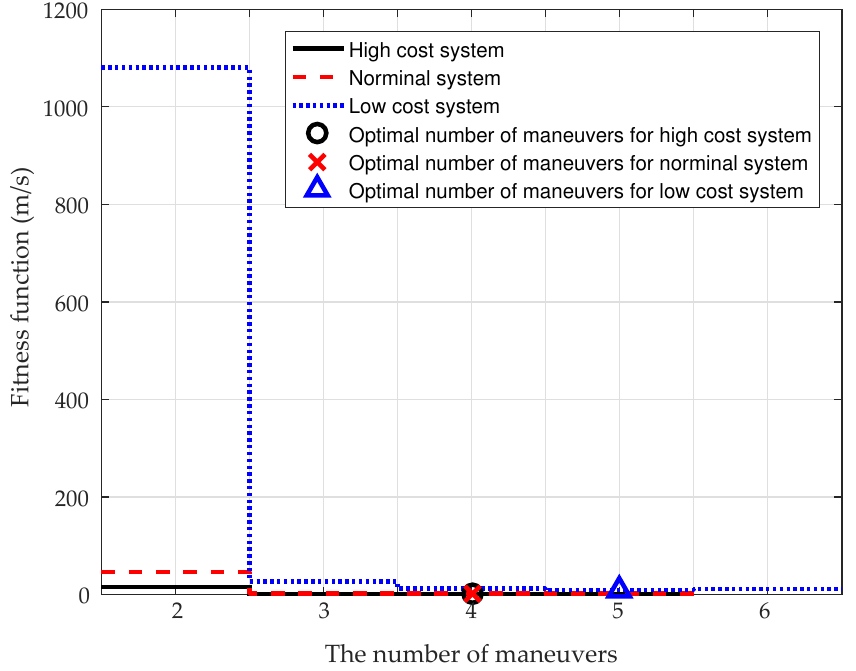
Figure 9. Optimal fitness function with respect to the number of maneuvers when t f = 12,000